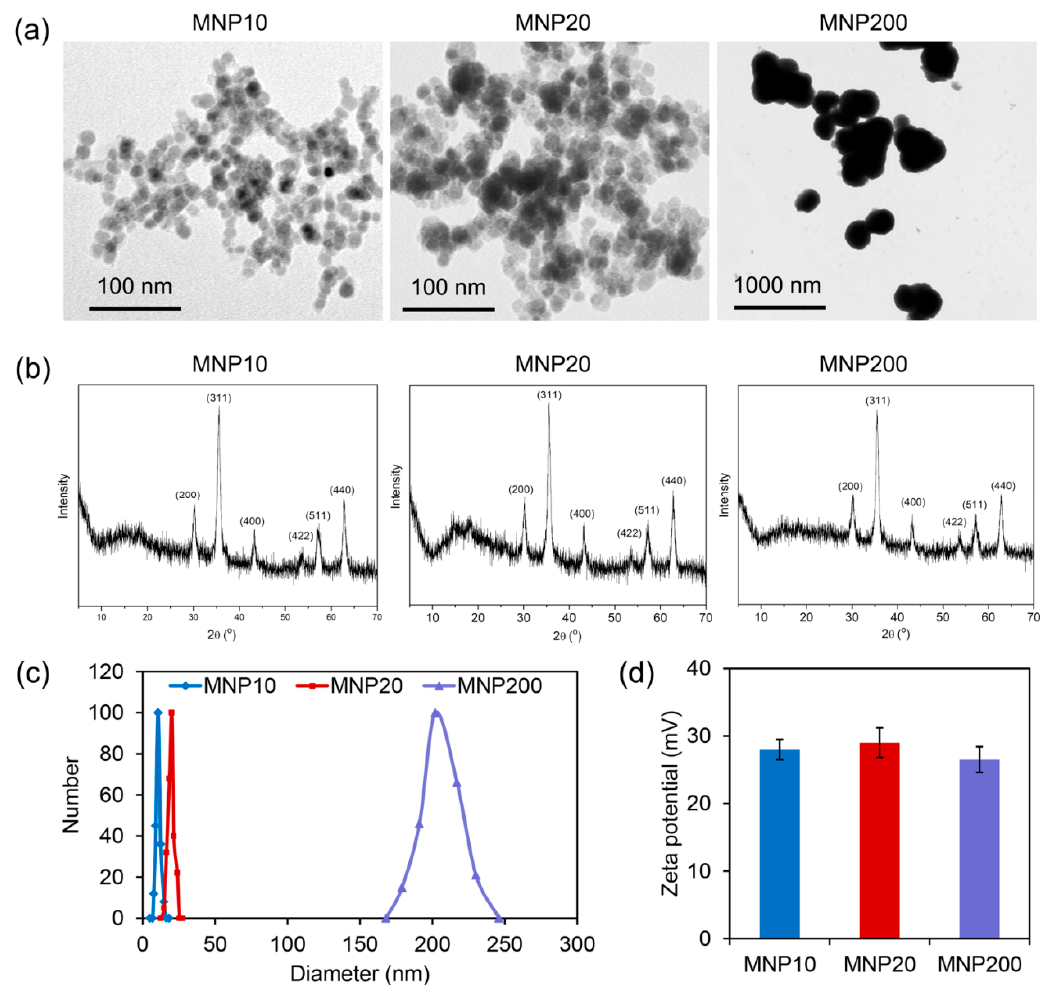
Figure 1. Characterization of the synthetic MNPs with different sizes. ( a ) TEM images of the syn- thetized nanoparticles MNP10 (size ≈ 10 nm), MNP20 (size ≈ 20 nm), and MNP200 (size ≈ 200 nm). ( b ) XRD patterns of the MNPs. ( c ) Size distribution of the MNPs revealed by DLS analyzer. ( d ) Zeta potentials of the MNPs.